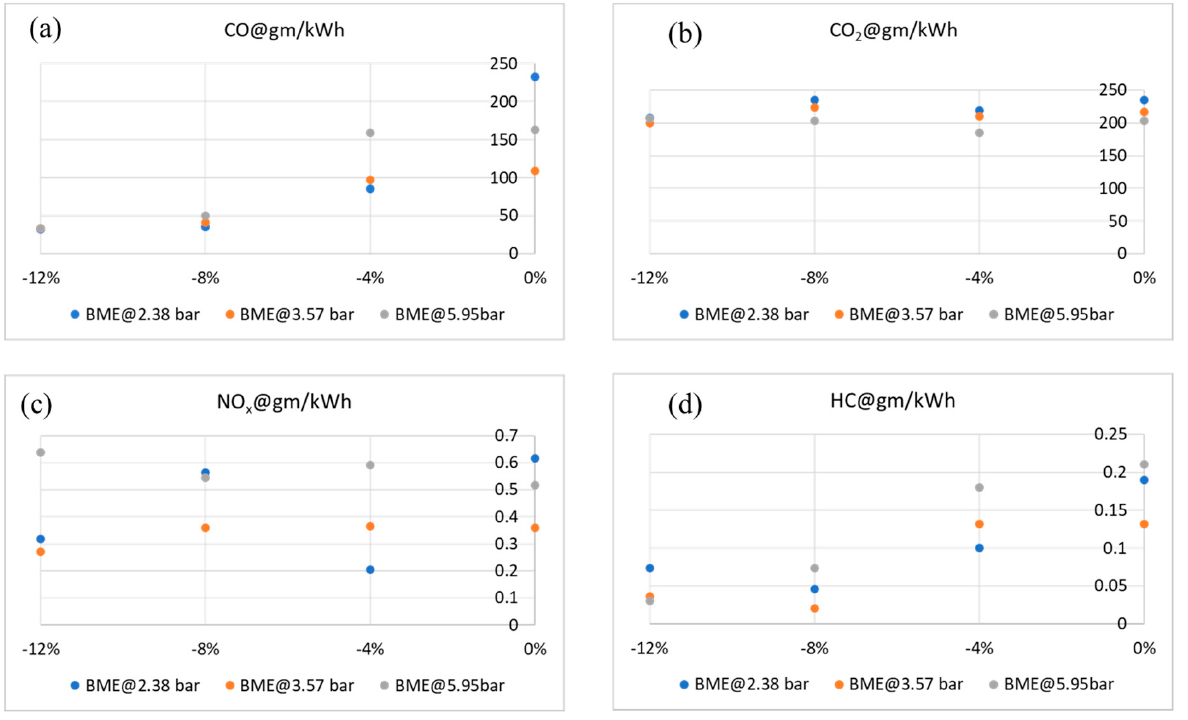
Figure 4. Fuel carbon redundancy effect on emission formation at 1500 rpm, CT@0.8 mm, and variable BMEP: ( a ) CO@gm/kWh; ( b ) CO 2 @gm/kWh; ( c ) NO x @gm/kWh; ( d ) HC@gm/kWh.